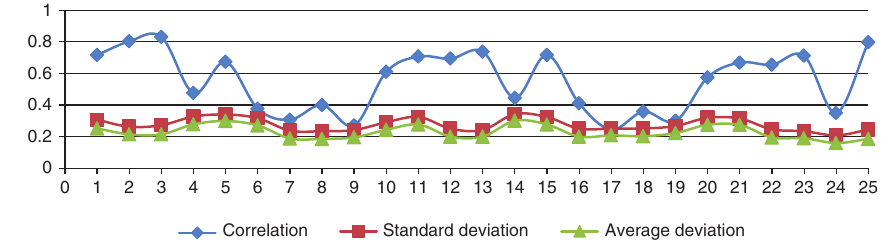
Figure 12: Sentence Similarity Measures Overall Comparison with Values from Lee et al. [21]. Table 3: Legend for the 25 Measures Shown in Figures 8–12.